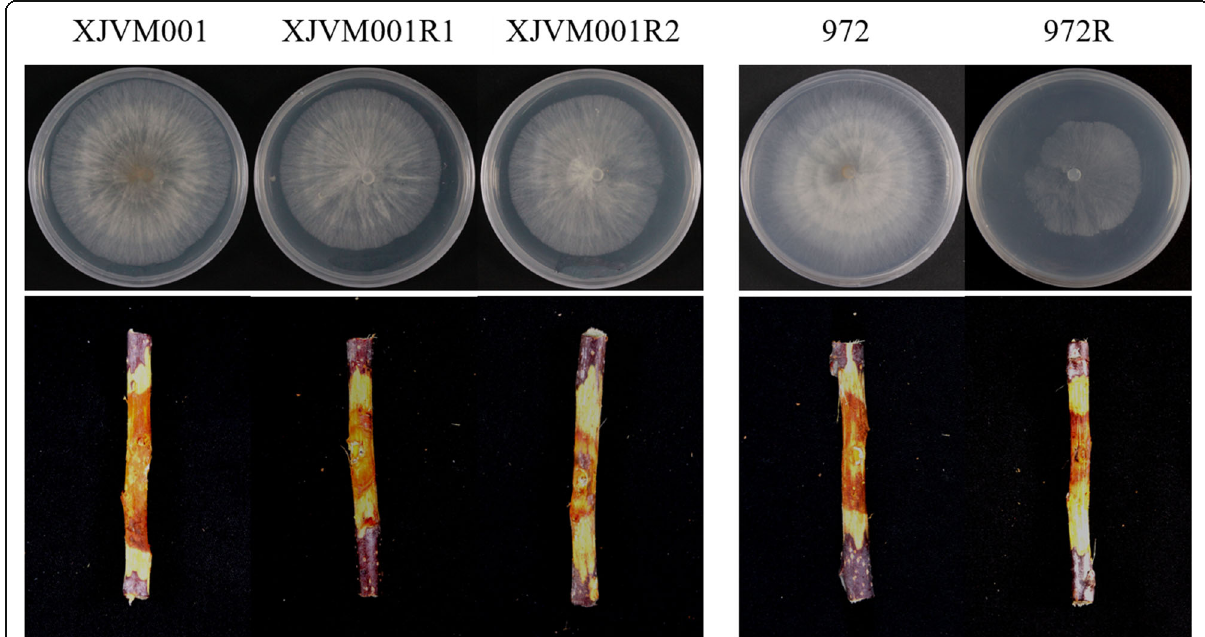
Fig. 2 Mycelial growth and pathogenicity of pyraclostrobin-resistant mutants of Valsa mali and their parent isolates. Colony diameters of PR mutants (XJVM001R1, XJVM001R2, 972R) and their parental isolates (XJVM001, 972) were measured after 60 h of incubation at 25 °C on PDA. Pathogenicity was evaluated by measuring the lesion size at 5 days post inoculation at 25